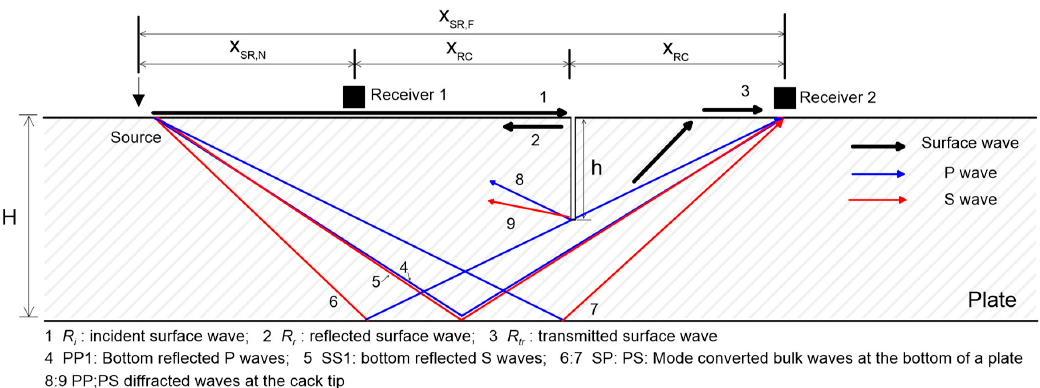
Figure 1. A typical source-to-receiver configuration for surface wave transmission measurements across a surface-breaking crack in a plate.